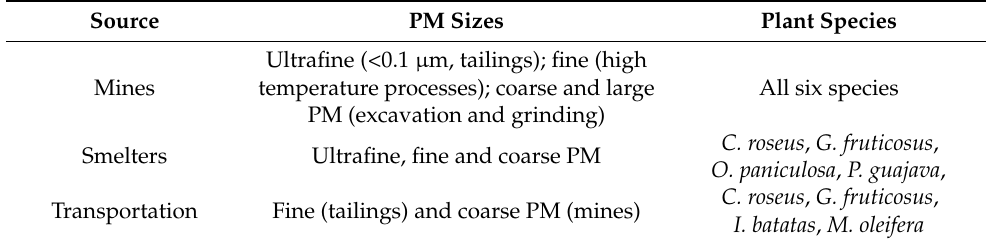
All six species